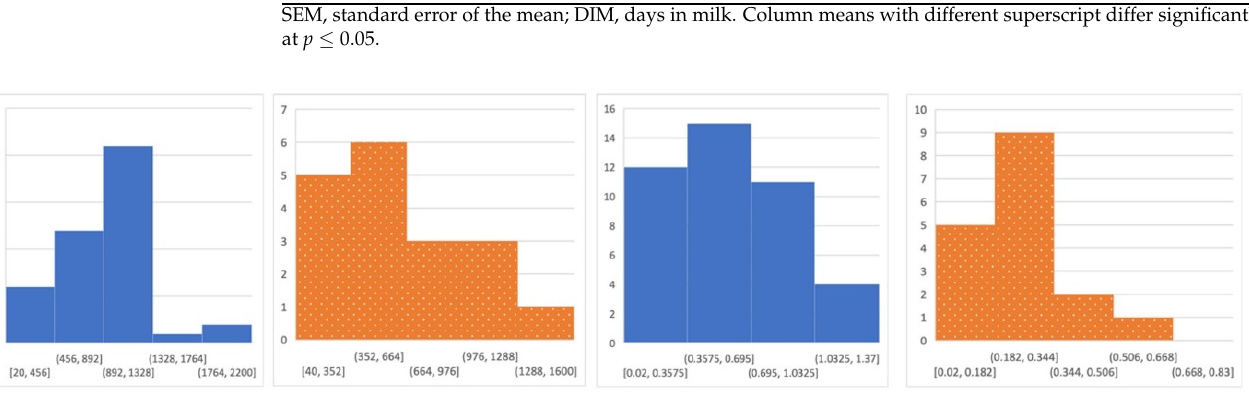
Table 1. Mean ± SEM for milk yield, milking speed, calving interval, and age at first calving in calm and nervous buffalo cows. SEM, standard error of the mean; DIM, days in milk. Column means with different superscript differ significantly at p ≤ 0.05.